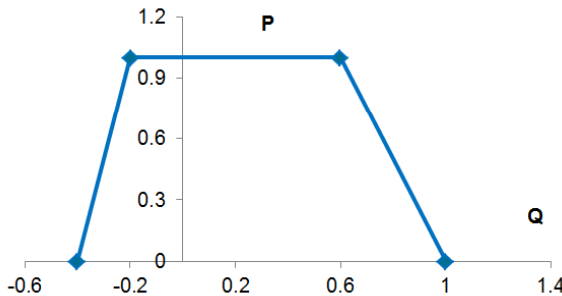
Figure 2. Capability curve of synchronous generators considered in the OPF model.